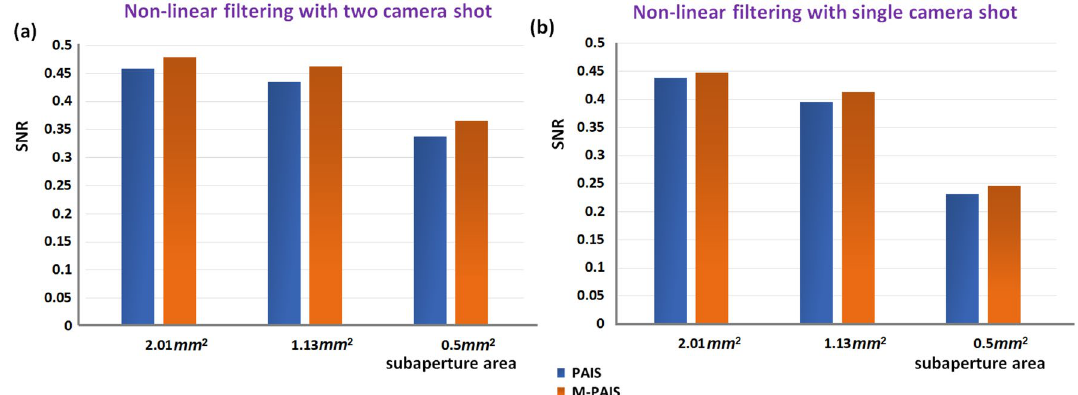
Figure 7. SNR of best NLR results obtained for M-PAIS and PAIS of ( a ) bipolar sparse holograms created from two-shot and ( b ) single hologram created from a single camera